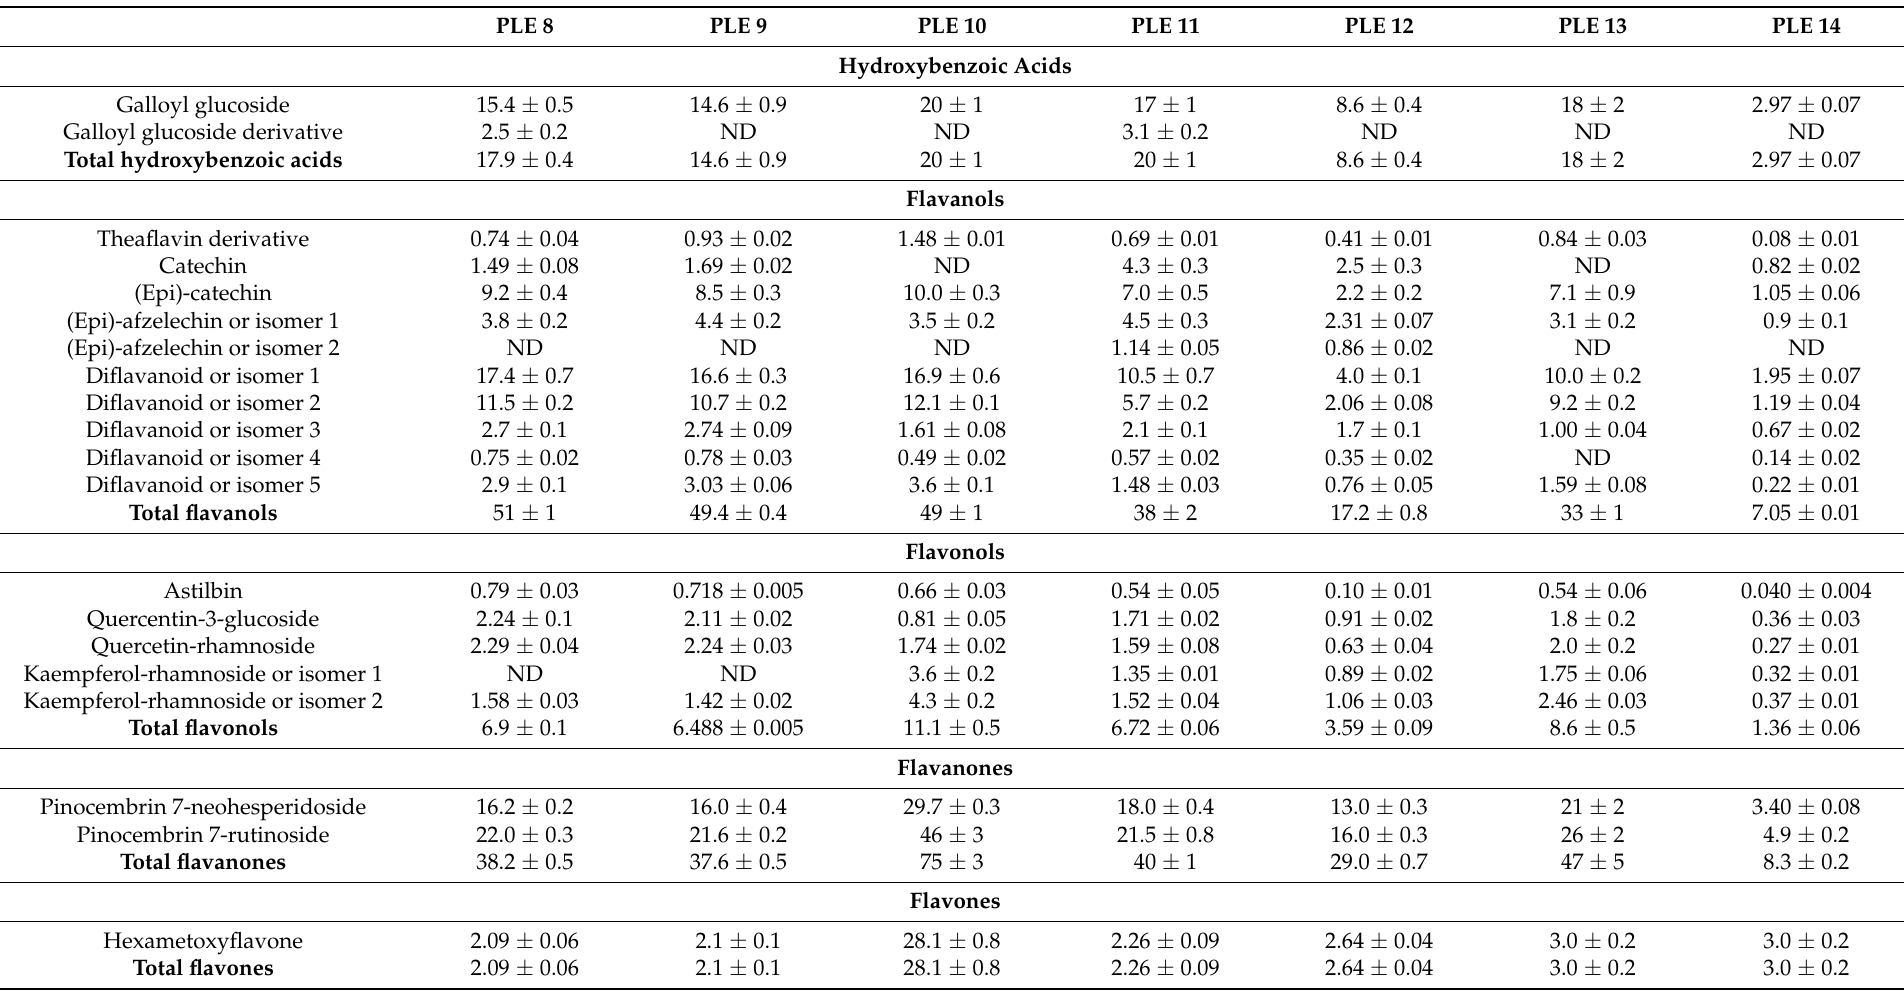
Table 6. Concentration of phenolic compounds in PLE extracts, ordered by families and expressed in mg compound/g extract (X ±